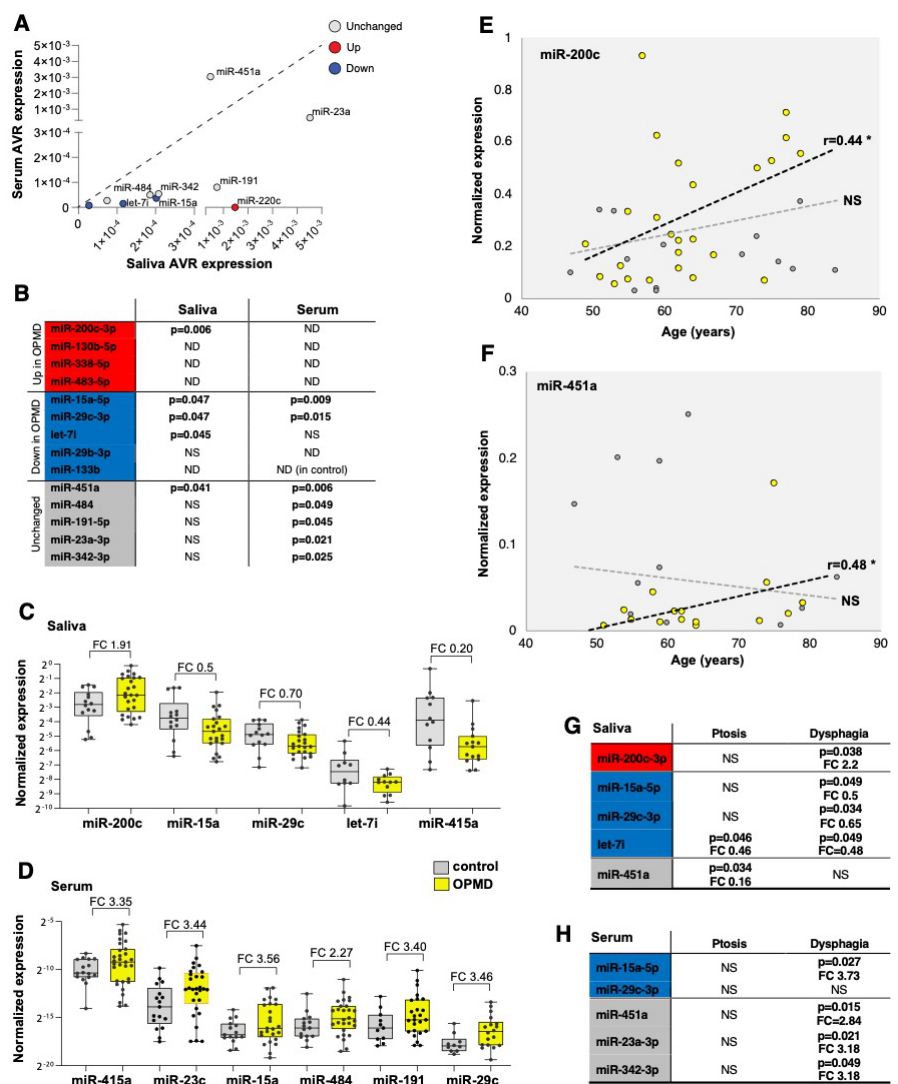
Figure 5. miRNA candidates for OPMD in serum and saliva. ( A ) Scatter plot shows average expression levels in saliva vs. serum. The dysregulation direction (up or down in OPMD muscles) is denoted in red or blue, respectively. miRNAs with unchanged levels in muscles are denoted in grey. The diagonal (1:1 ratio) is denoted with a dashed line. ( B ) A summary qRT-PCR for 14 miRNAs in serum or saliva. p -value ( p < 0.05) indicates a significant difference between control and OPMD. miRNAs that are higher in OPMD muscles are in red, those with lower expression levels in blue, and unchanged in grey. p -values were determined with an unpaired t -test, Welch corrected. ND, undetected; NS, not significant. miR-133b was not detected in serum from controls. ( C , D ) Box plots show expression levels in saliva ( C ) and serum ( D ) in control and OPMD groups of the significantly differentially expressed miRNAs. Fold-change (FC) is depicted. Every subject is denoted with a dot. The fold-change of all the differentially expressed miRNAs in serum has an opposite direction than in OPMD muscles. ( E , F ) An age-associated expression level is visualized with a scatter plot. Significant correlation (Pearson, p < 0.05, denoted with *) was found only for in miR-200c and miR-451a in saliva, and only for the OPMD samples. NS = not significant. Correlation coefficient (r) is denoted next to the regression line (dashed lines). A thin dashed line denoted the regression line of the controls and the bold line denotes the OPMD samples. ( G , H ) A summary of miRNA differential expression analysis per initial symptom, ptosis ( n > 12) or dysphagia ( n > 16). The p -value (unpaired t -test) and fold-change (FC) are denoted for the significantly differentially expressed miRNAs.